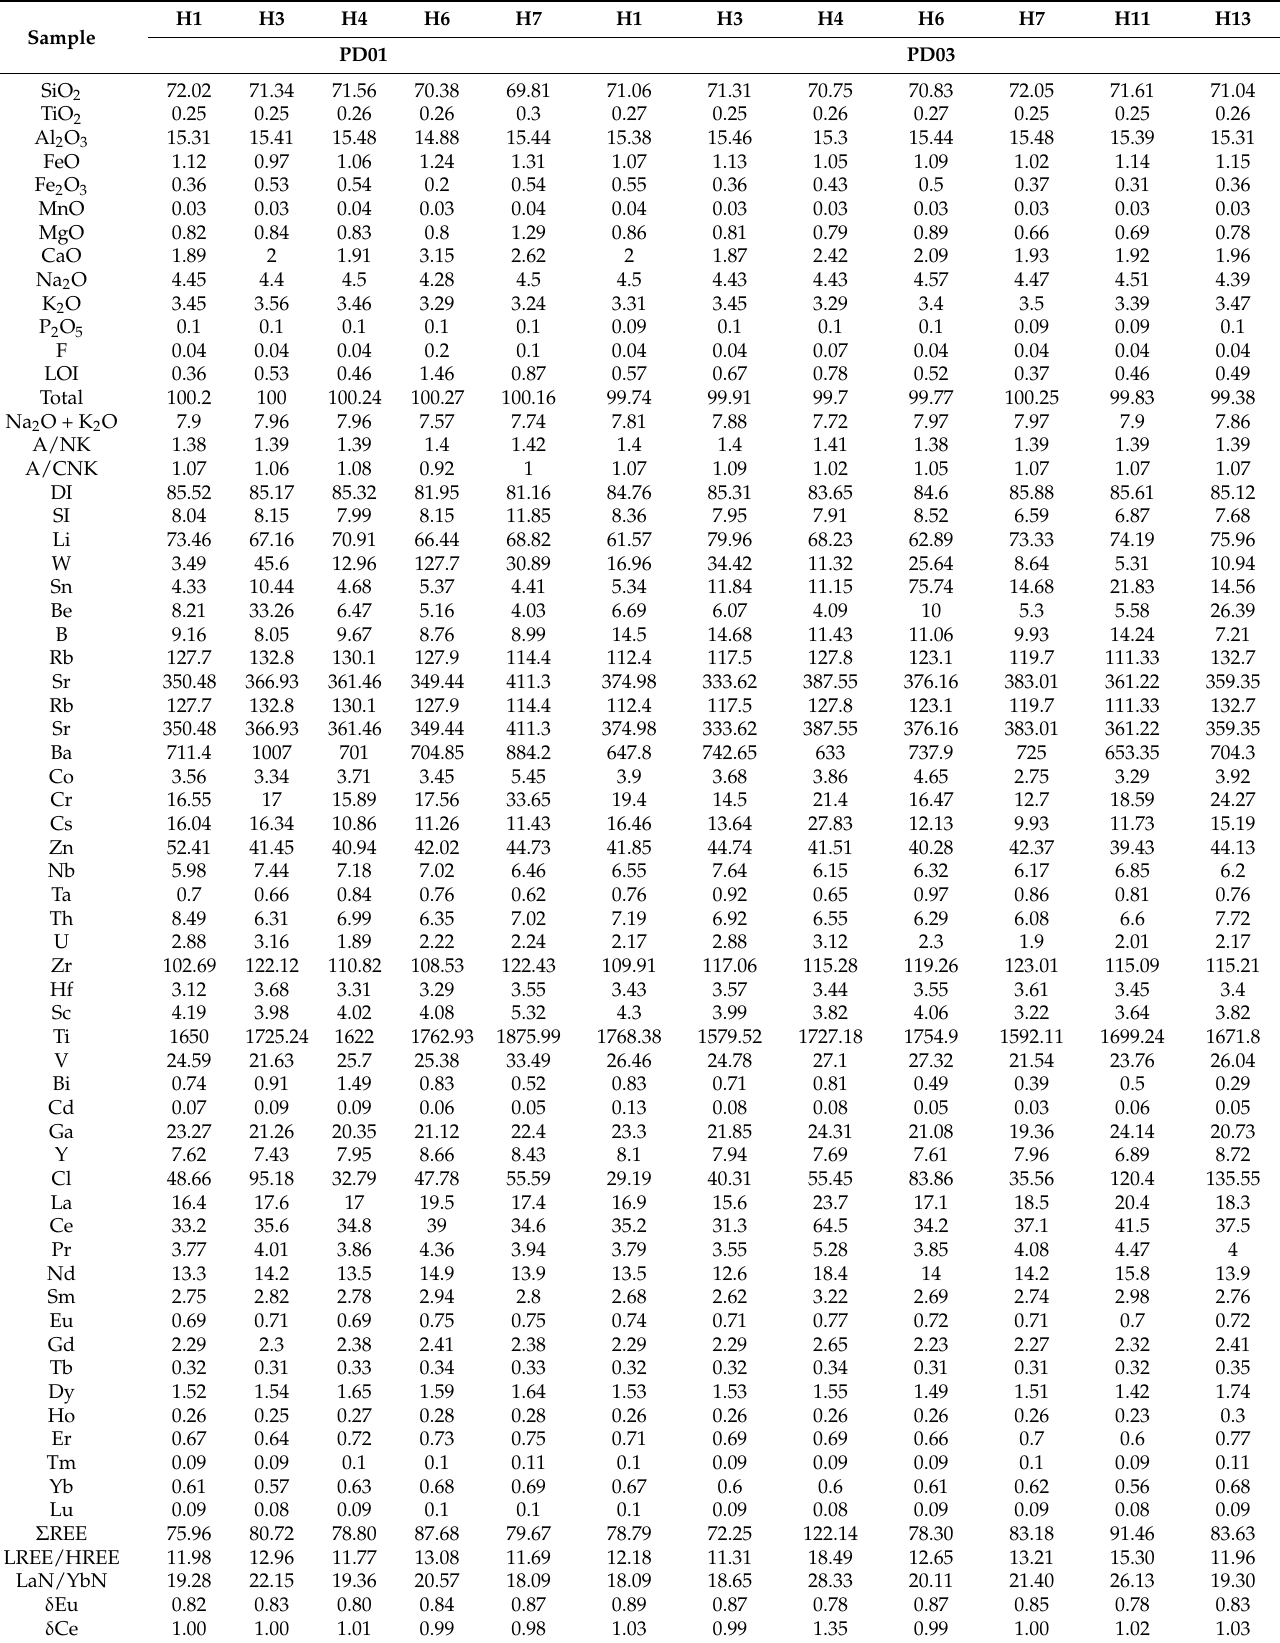
Table 3. Analysis results of the major (wt.%) and trace (ppm) elements of the Wuzhutang granite from the Xuebaoding mining